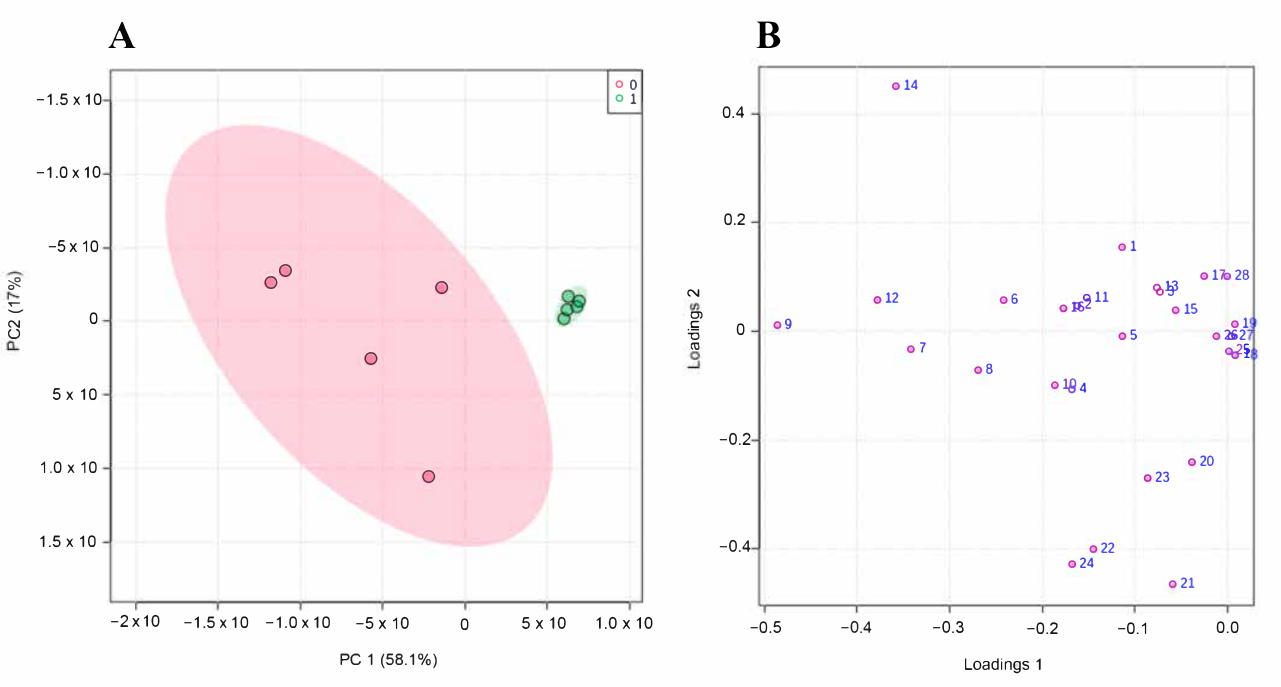
Figure 4. PCA results from the untargeted metabolomics experiment. ( A ) 2D scores plot of the first principal component (PC1) versus the second principal component (PC2) for control ( n = 5) (red area) and cells treated with 5 µ g/mL of AgNPs for 72 h ( n = 5) (green area). ( B ) Loadings plot of PC1 versus PC2 for the 28 quantified metabolites (the number of each metabolite correlates with the identified metabolites as shown in Supplemental Table